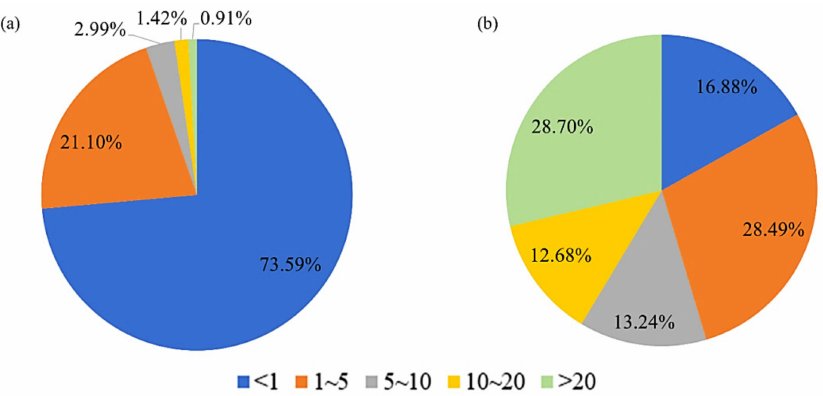
Figure 12. Statistics of glaciers of different sizes on the Tibetan Plateau: ( a ) the percentage of the number of glaciers of different sizes; ( b ) the percentage of the area of glaciers of different sizes.